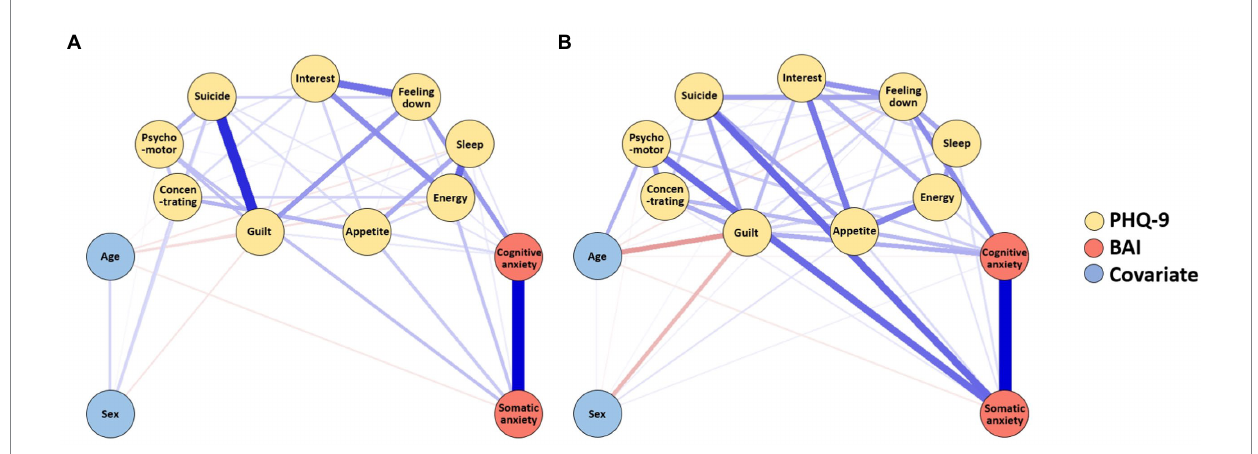
FIGURE 1 Estimated networks of depression and anxiety before (A) and during (B) the pandemic. Somatic anxiety, somatic subscale of the Beck Anxiety Inventory; Cognitive anxiety, cognitive subscale of the Beck Anxiety Inventory; Feeling down, item 1 of the Patient Health Questionnaire-9 (PHQ-9); Interest, item 2 of the PHQ-9; Sleep, item 3 of the PHQ-9; Appetite, item 4 of the PHQ-9; Psychomotor, item 5 of the PHQ-9; Energy, item 6 of the PHQ-9; Guilt, item 7 of the PHQ-9; Concentrating, item 8 of the PHQ-9, Suicide, item 9 of the PHQ-9. The blue edges indicate positive partial